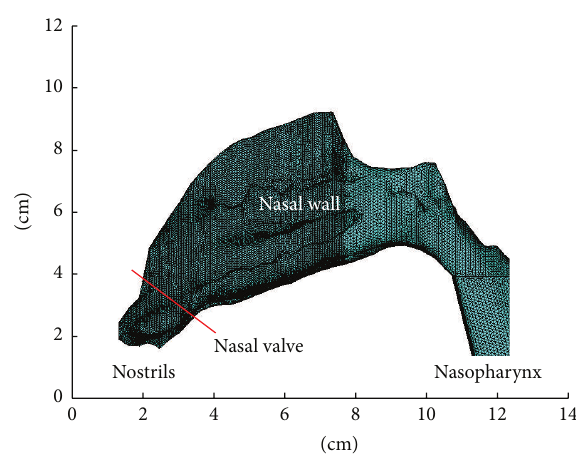
Figure 2: The three-dimensional finite element model of a nasal